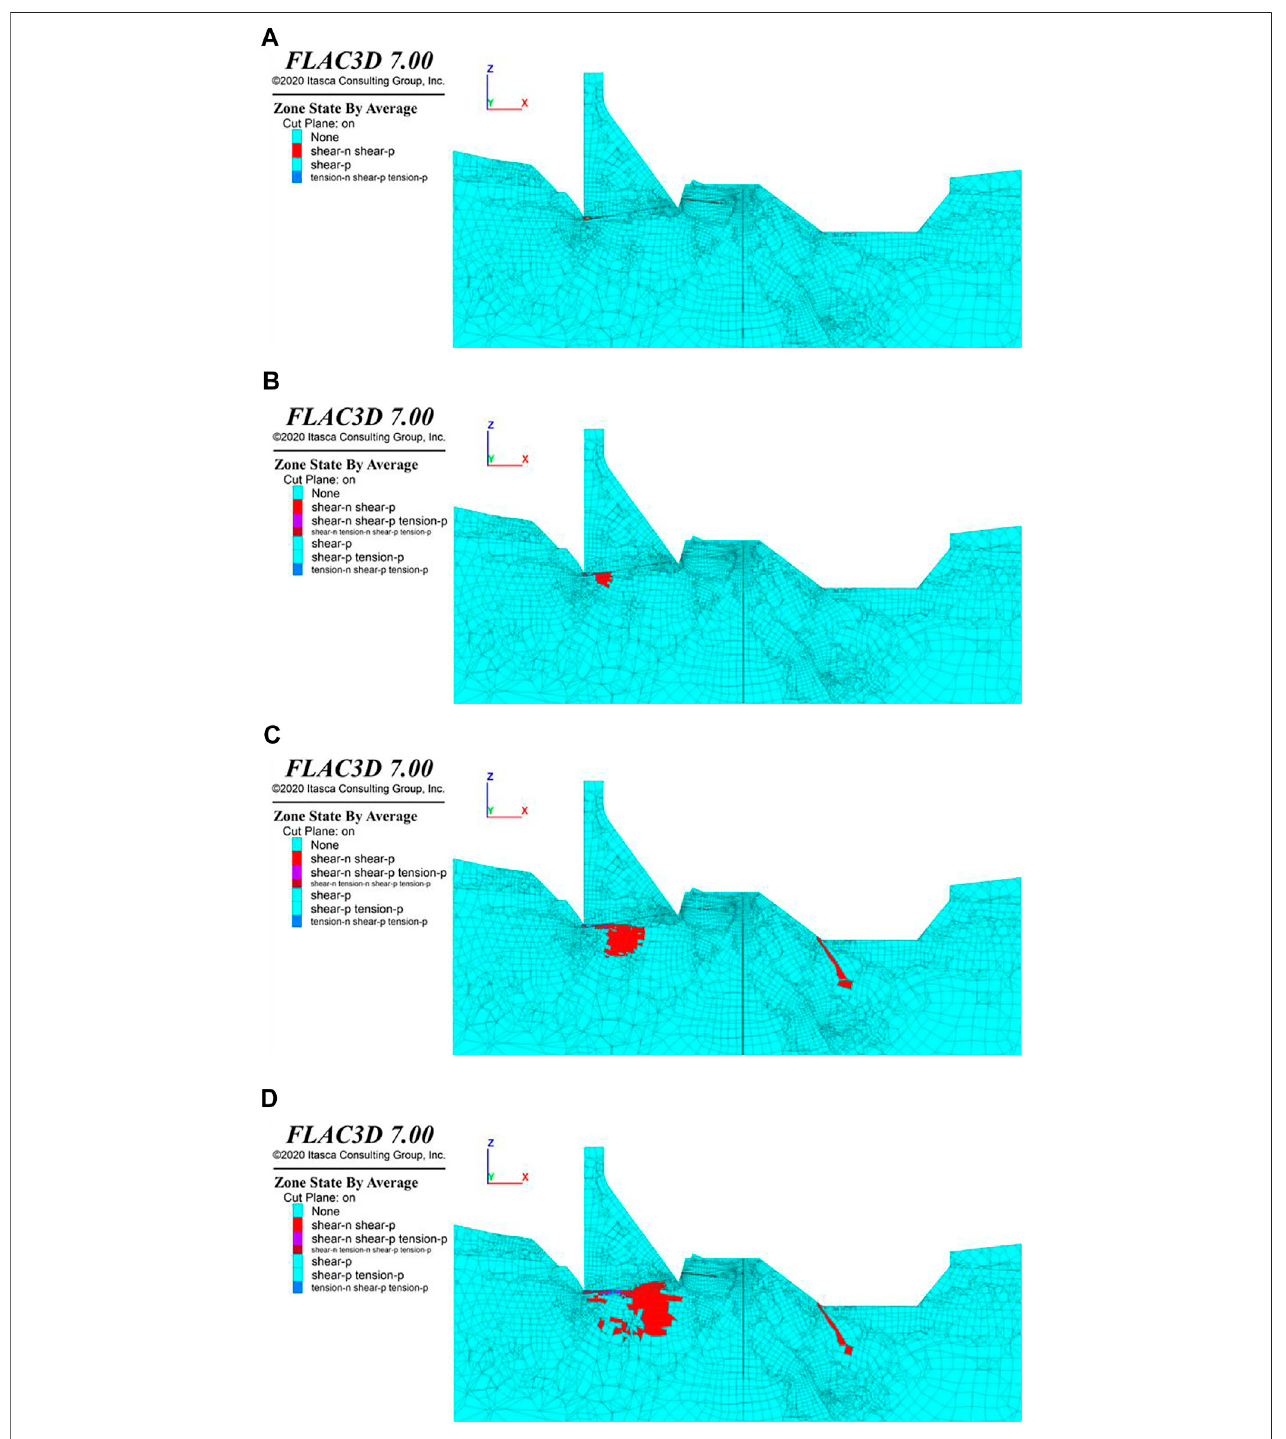
FIGURE8 | Plastic zones in the pro fi le cutting through thecenter ofdam section 3 under the conditions of (A) overload coef fi cient 2.0, (B) overload coef fi cient 3.0, (C) overload coef fi cient 4.0, and (D) overload coef fi cient 5.0.